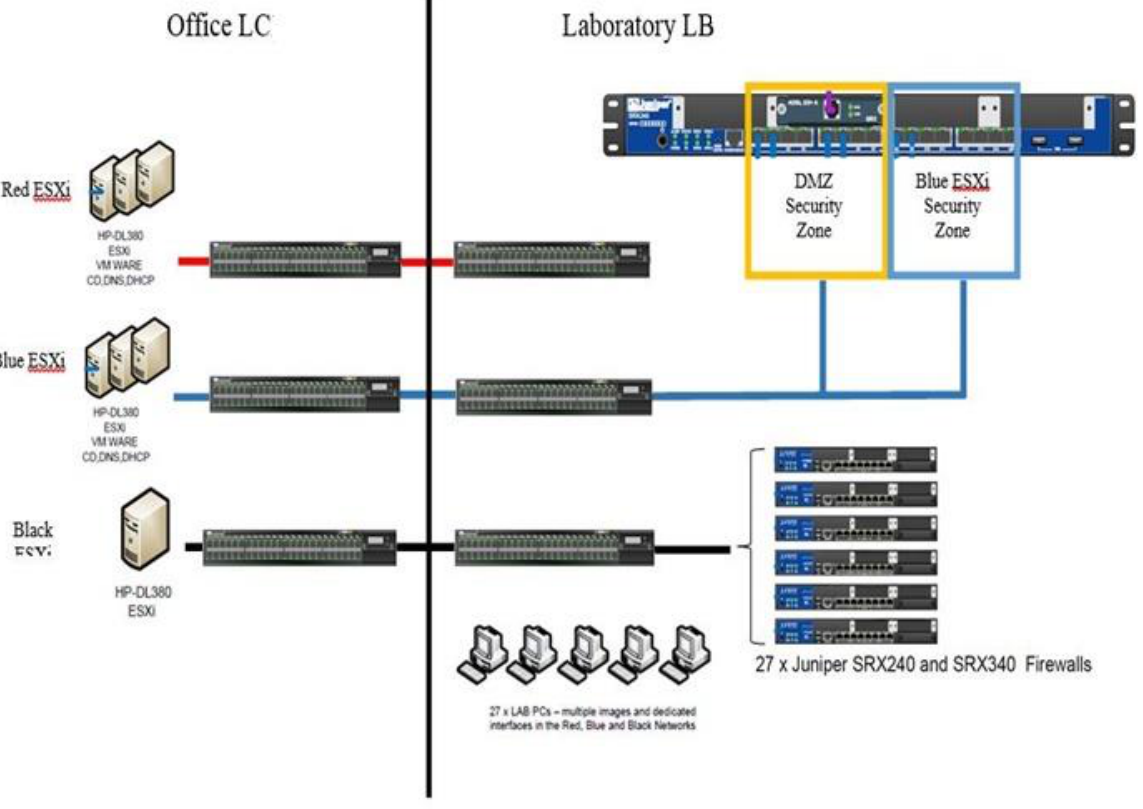
Figure 2. Architecture of System .